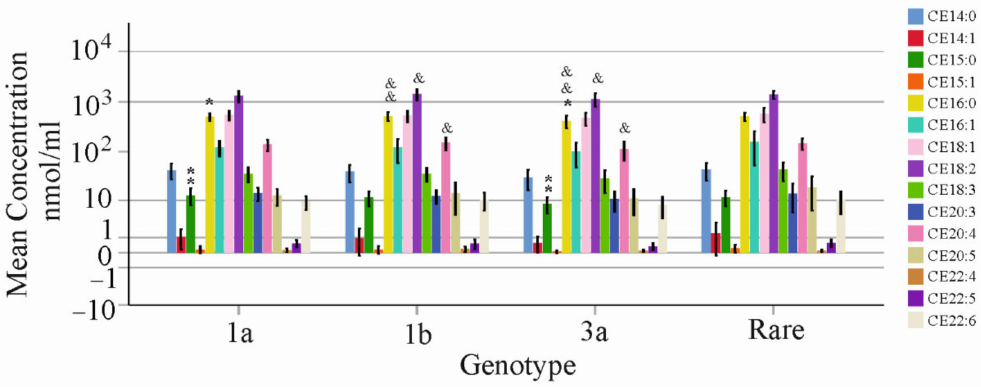
Figure 8. Cholesteryl ester (CE) species in relation to viral genotype before therapy. CE species in the serum of patients without liver cirrhosis before therapy. * p < 0.05, ** p < 0.01 for comparison of genotype 1a and 3a, and & p < 0.05, && p < 0.01 for comparison of genotype 1b and